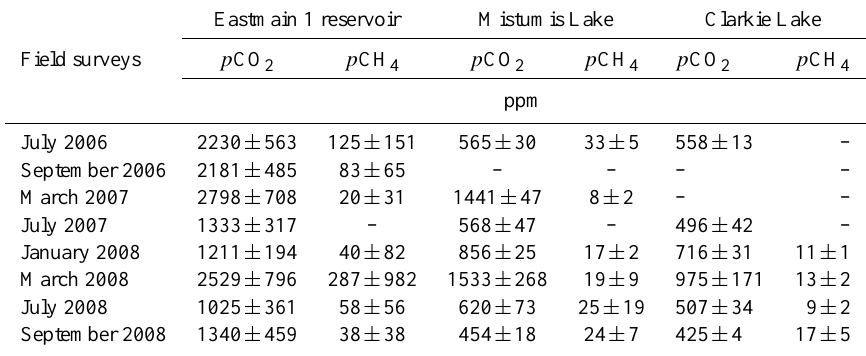
Table 3. Mean surface p CO 2 and p CH 4 ( ± standard deviation) measured at Eastmain 1 reservoir, Mistumis Lake, Clarkie Lake, Robert Bourassa reservoir, Duncan Lake and Yasinski Lake. The number of replicates corresponds to the number of sampling stations given in Table 2. Eastmain 1 Field surveys